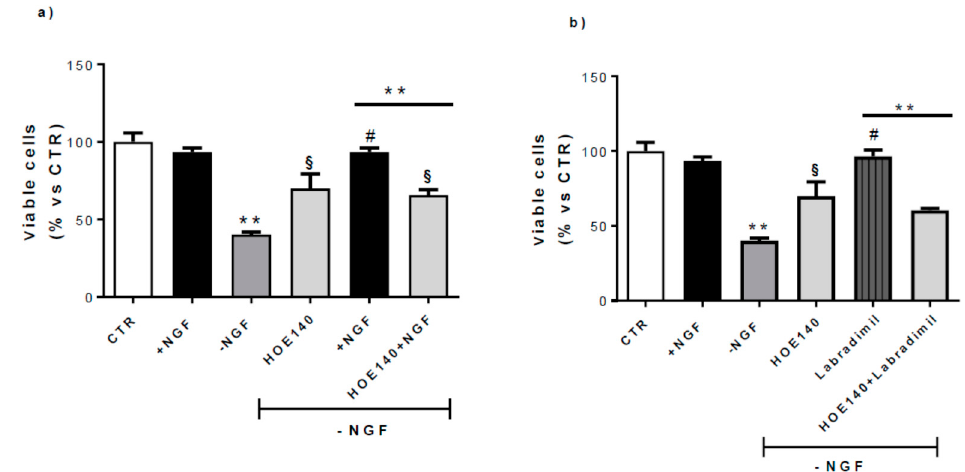
Figure 5. E ff ect of B2R antagonism on CN viability. At 10 DIV, CNs cultured in Neurobasal + 1% B27 (CTR) were treated for 48 h with NGF 100 ng / mL ( + NGF) and afterwards deprived of NGF for 24 h by washing ( − NGF) or rescued by 24 h NGF replacement ( + NGF). Neuronal viability was determined by counting intact nuclei and expressed considering 100 as the number of viable neurons in CTR conditions. ( a ) Treatment with HOE140 (1 µ M), a selective B2R antagonist, induced a considerable inhibitory e ff ect on the neuroprotection promoted by NGF replacement (HOE140 + NGF). ( b ) In the same conditions, HOE140 significantly antagonized the neuroprotective activity exerted by RPM-7, a selective B2R agonist (RPM-7 (100 nM). Data represent means ( ± S.E.M.) from four duplicate experiments. Statistically significant di ff erences were calculated by one-way analysis of variance (ANOVA) followed by Bonferroni’s test (** p < 0.01 versus + NGF; # p < 0.01 versus − NGF; § p < 0.01 versus − NGF).